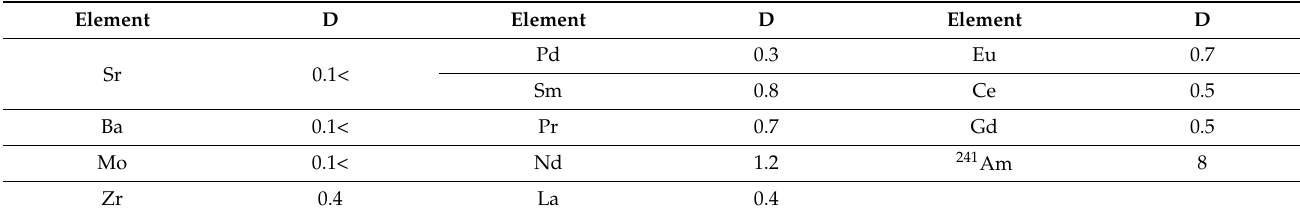
Table 4. Distribution ratios of the HLW imitator solution used in this